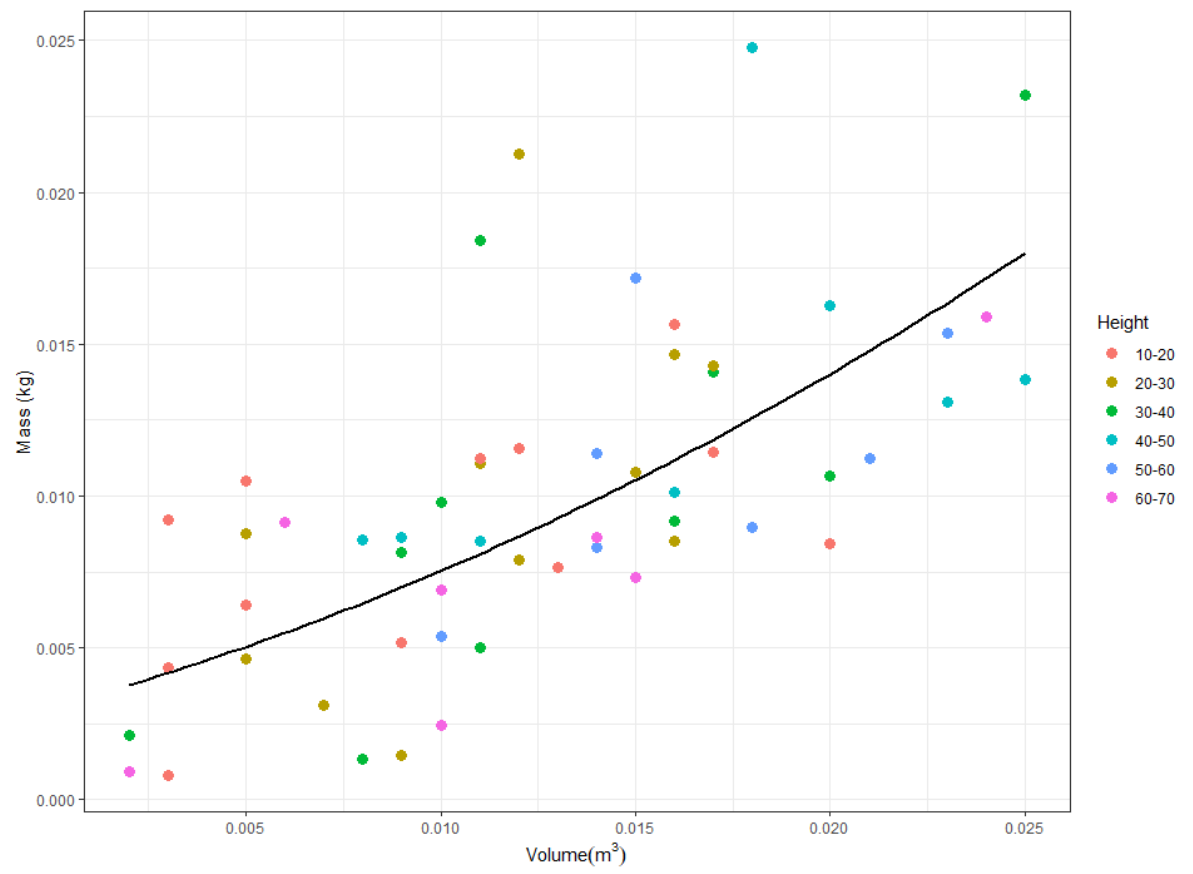
Figure 2. Regression for live woody fuel material with volume as a predictor of mass (mass has been backtransformed from square root). The equation was significant ( p < 0.001), with an R 2 of 0.44. Only mass and volume observations associated with the strata between 10 and 70 cm were included. Table 2. Estimates, R 2 , and residual standard errors for linear and nonlinear regression equations for the three fuel types predicting mass (kg) based on volume and height. For live woody, only volume was used as a predictor. Standard deviation of estimates in parentheses.